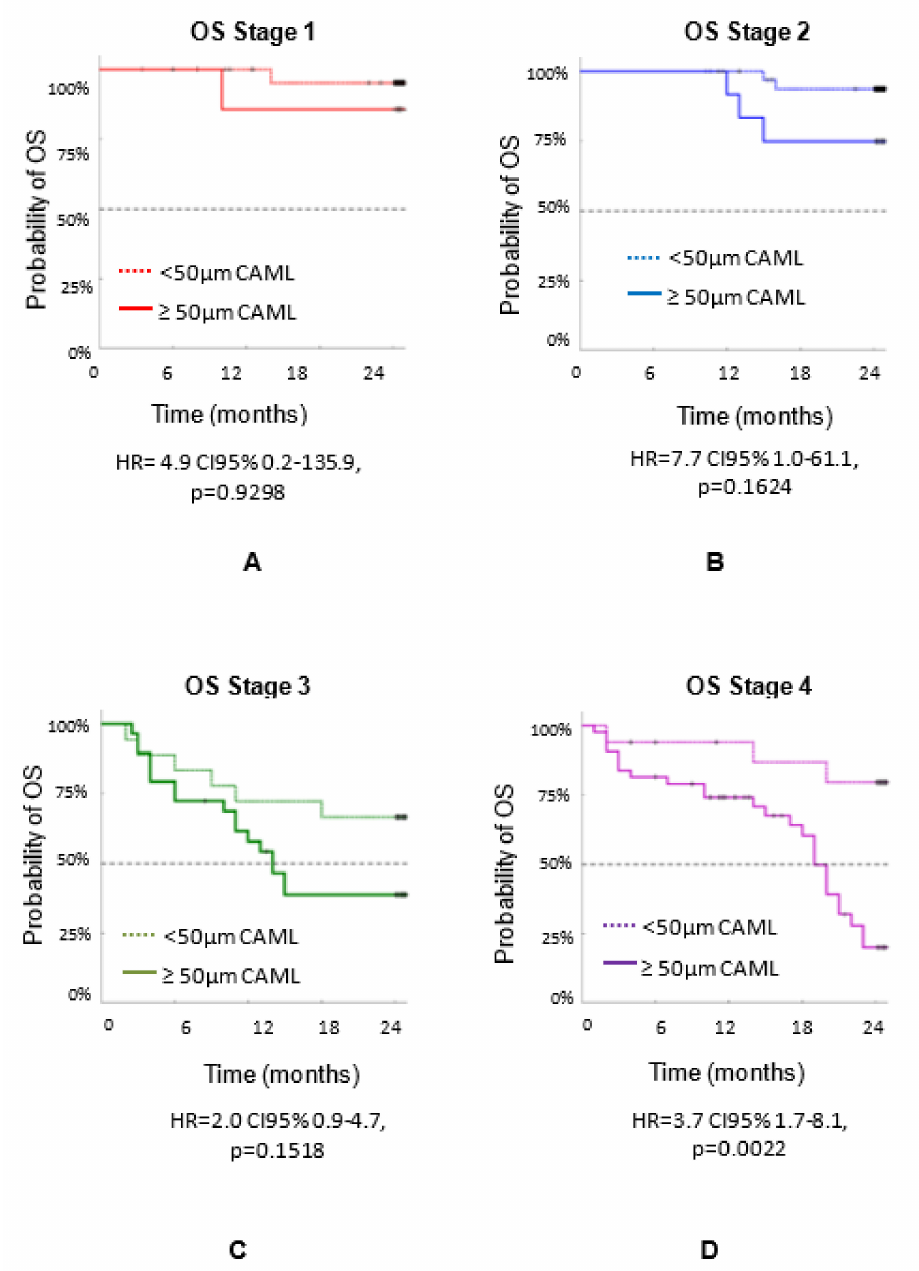
Figure 6. OS of n = 192 patients with three types of cancers (breast, prostate and lung) by stage. OS based on CAML size at each stage of cancer determined during a 24-month follow-up: ( A ) Stage 1, ( B ) Stage 2, ( C ) Stage 3 and ( D ) Stage